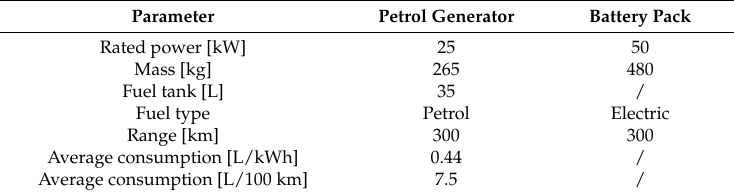
Table 3. Overview of the trailer characteristics for a petrol generator and an additional battery pack.